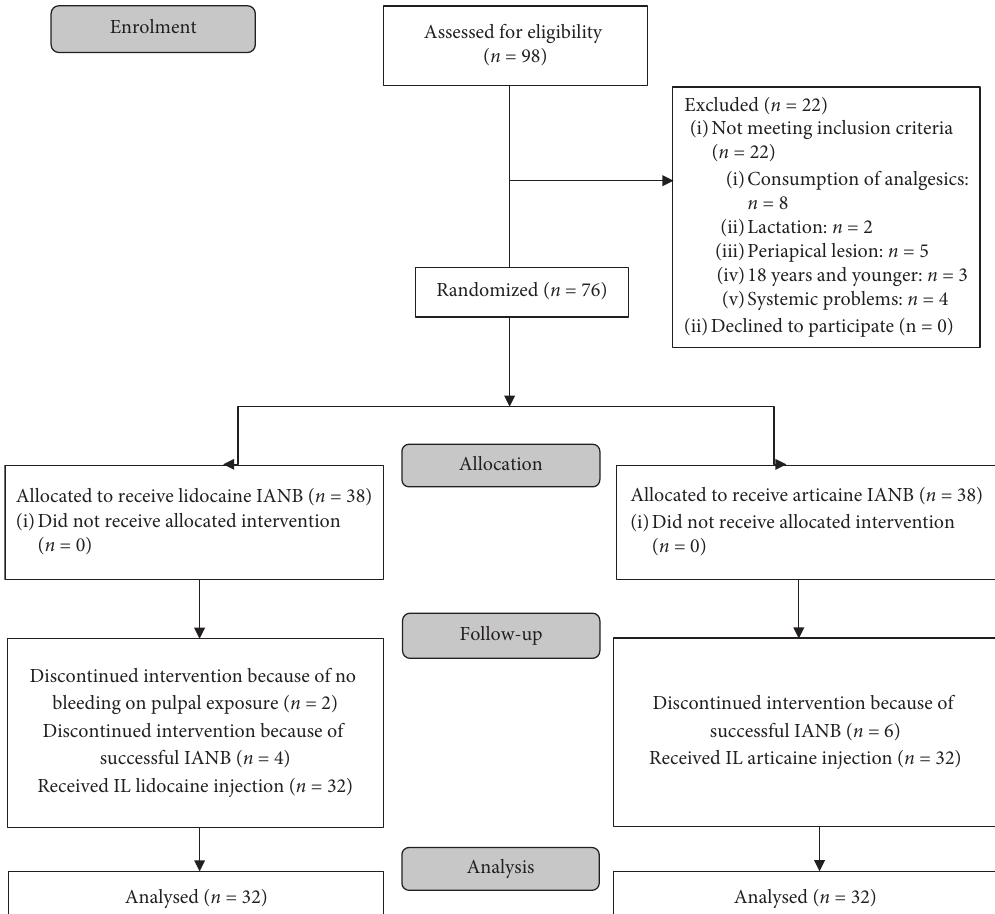
Figure 1: Consort flow diagram (IANB � inferior alveolar nerve block, IL �